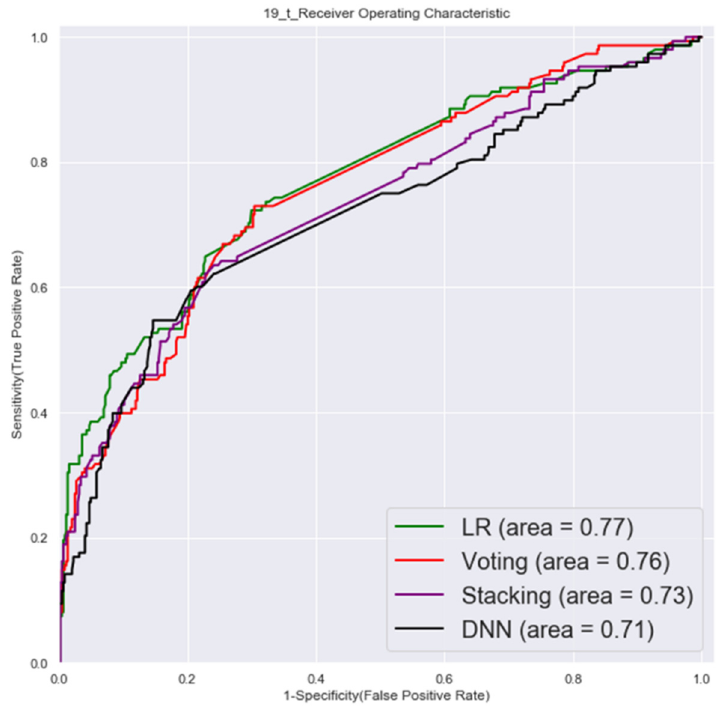
Figure 5. Validation set ROC (second factor combinations).